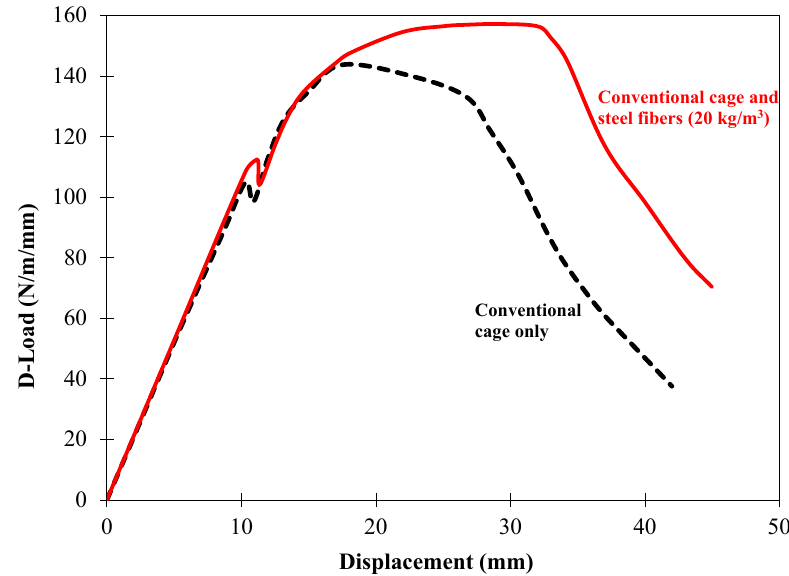
Figure 17. Load ‐ deflection curves of the pipes tested under the three ‐ edge bearing condition.